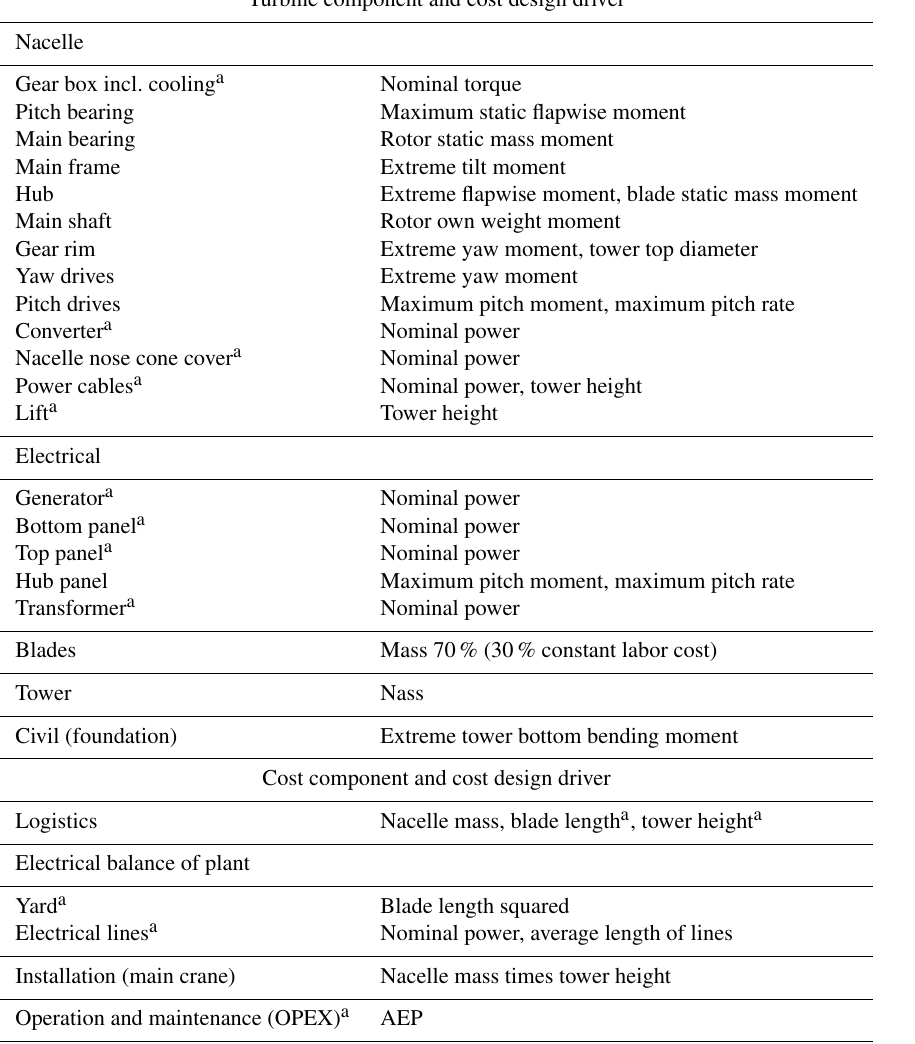
Table 2. Cost drivers (CDs) for turbine cost and mass split by main cost